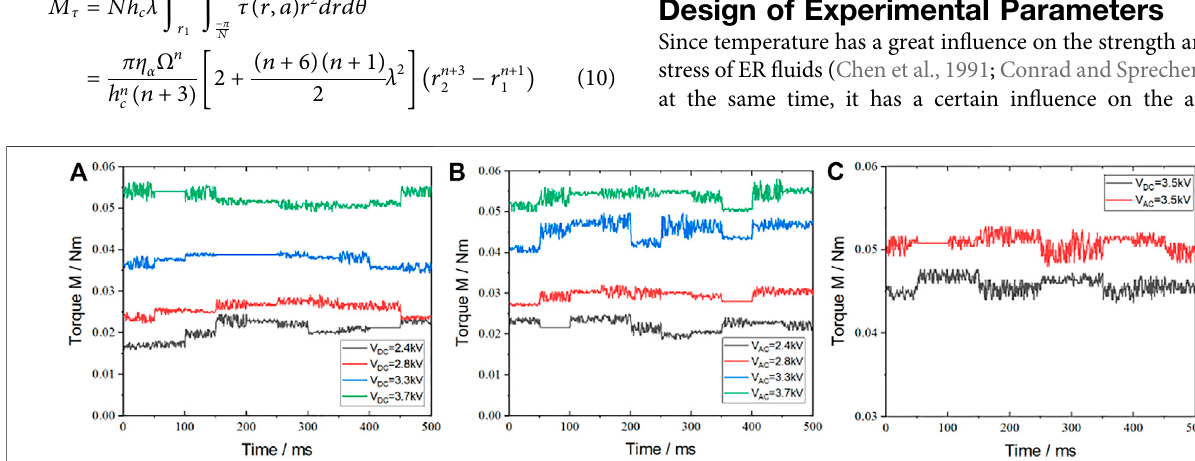
Frontiers in Materials |